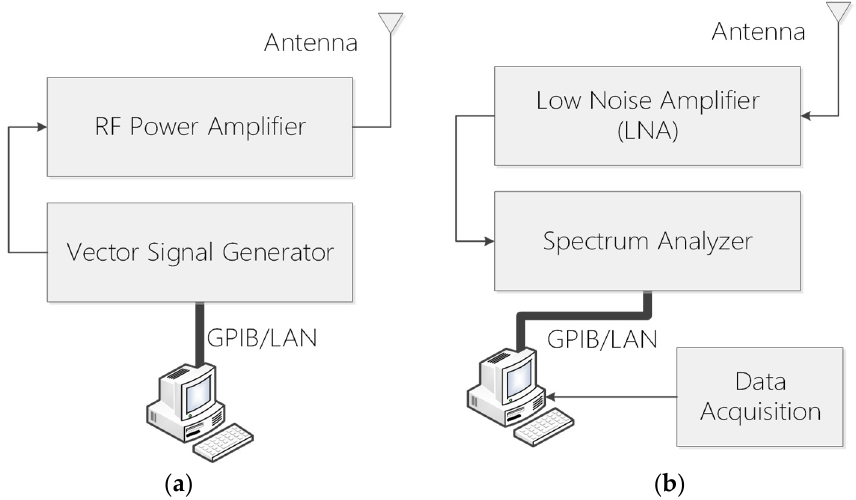
Figure 3. Block Diagram of: ( a ). Transmitter site equipment ( b ). Receiver site equipment.